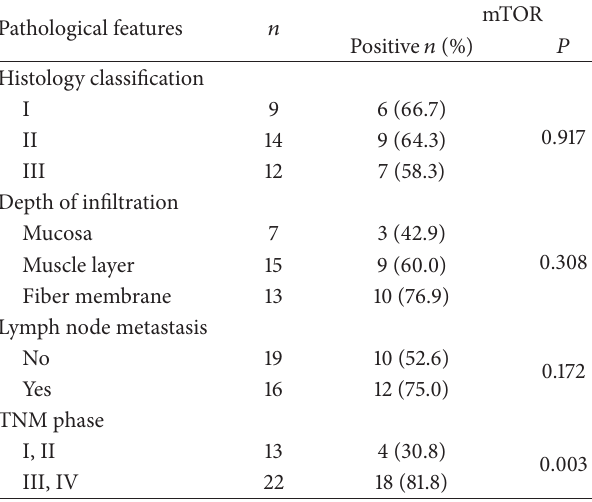
Table 2: Clinical significance of mTOR protein